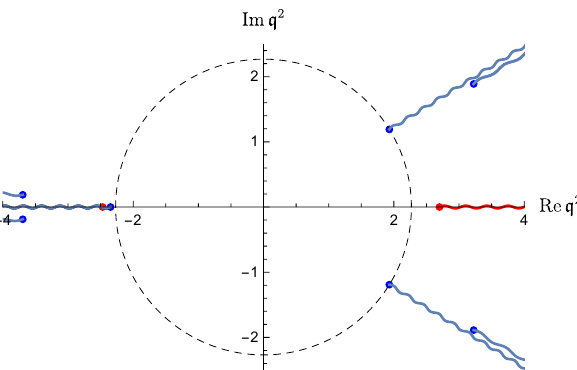
Figure 4 . The closest to the origin branch points (see table 1) of the N = 4 SYM shear mode dispersion relation w = w ( q 2 ) in the complex q 2 -plane at γ = 1 · 10 − 5 . The critical points seen in perturbation theory and their branch cuts are shown by blue colour, the two non-perturbative critical points on the real axis are shown in red. The radius of convergence at γ = 1 · 10 − 5 , R shear ≈ 2 . 27 , is determined by the pair of branch points at q 2 ≈ 1 . 93 ± 1 . 19 i . We note that it is the sole inclusion of the non-perturbative red critical point on the positive real q 2 -axis that leads to the non-perturbative result of figure 3.